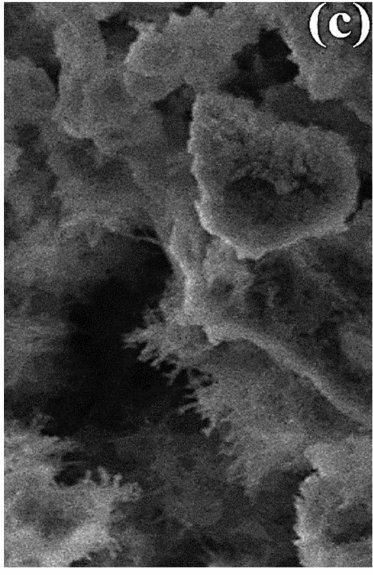
Figure 3. An insert from VP-SEM images of Figure 2, ( a ) SiO 2 SilB sample, ( b ) SiO 2 Siland sample without dispersion, and ( c ) SiO 2 Silad3.5 sample with dispersion.